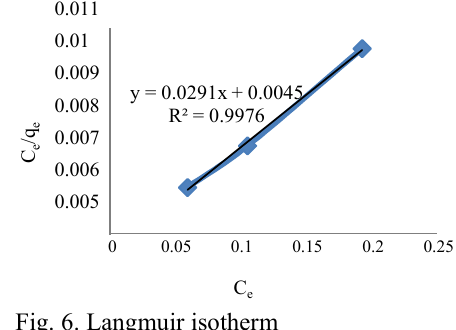
Fig. 6. Langmuir isotherm